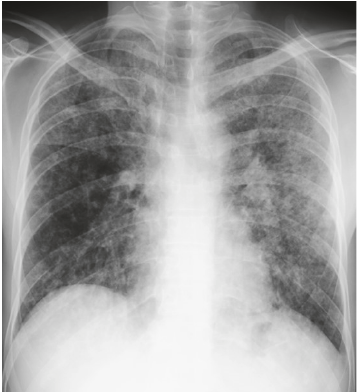
Figure 1: A chest radiograph obtained on the day of admission showed bilateral diffuse alveolo-interstitial infiltration, particularly in the left lung.